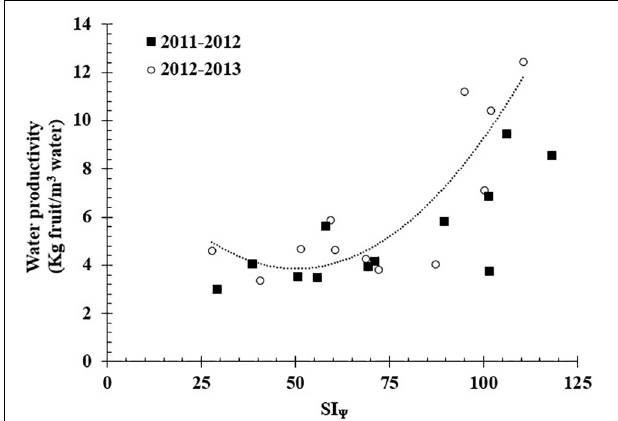
FIGURE 4 | Relationship between integral water stress (SI (cid:57) ) and water productivity (WP = 0.0022SI (cid:57) 2 –0.2206SI (cid:57) +9.396; R 2 = 0.74) in a grafted Carménère vineyard during the 2011/12 and 2012/13 growing